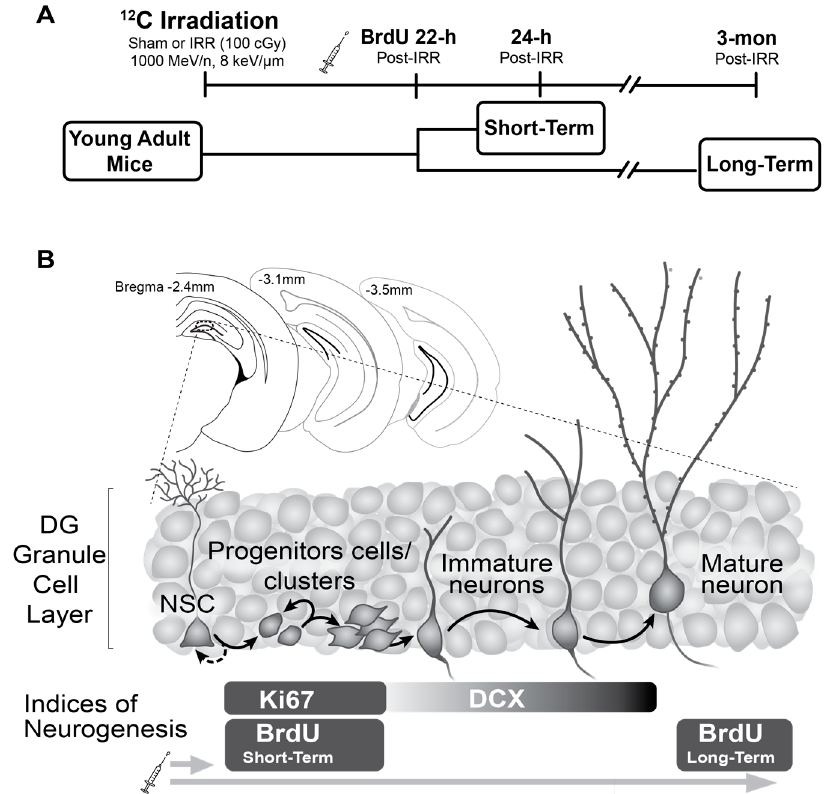
Figure 1. Schematic of experimental design and overview of neurogenesis indices examined. ( A ) Timeline of the experimental design used to investigate the Short- and Long-Term (24 h and 3-mon post-irradiation, respectively) effects of whole-body 12 C irradiation in young adult mice (9–11 wks at the time of irradiation) on dentate gyrus (DG) neurogenesis. All mice received the mitotic marker bromodeoxyuridine (BrdU) 22-h post-irradiation, with brains collected at a Short-Term or Long-Term time point. ( B ) Graphical representation of the mouse brain region that was the focus of this study. Upper left schematics depict three representative bregma coronal hemisections through the rostral, middle, and caudal hippocampal DG [122]. Main image depicts enlarged DG granule cell layer (GCL). Cells across the stages of DG neurogenesis are shown in the magnified GCL: neural stem cells (NSC), proliferating cells and clusters, immature neurons, and mature DG granule cell neurons. As indicated by the indices of neurogenesis on the bottom, proliferating cells/clusters can be labeled with antibodies against the endogenous proteins Ki67 or the exogenous thymidine analog BrdU (if examined shortly after BrdU injection), immature neurons can be labeled with an antibody against doublecortin (DCX), and surviving granule cell neurons can be labelled with an antibody against BrdU (if examined several weeks after BrdU injection). Figure modified from [41].